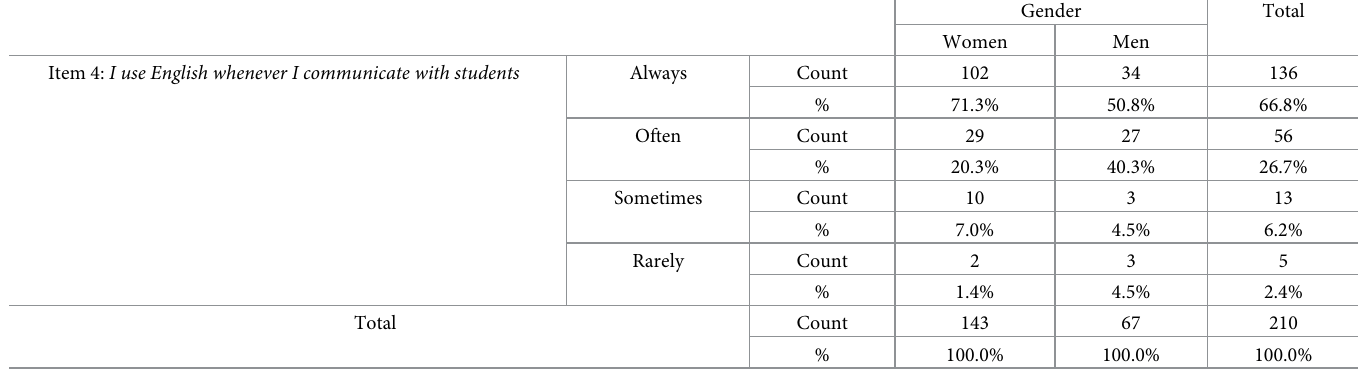
Table 7. English use for communication with